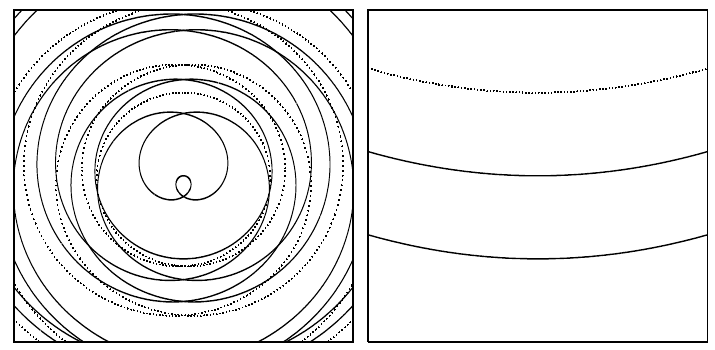
Fig. 3. Star tracks in the focal plane of the “Lyra-B” telescope pointed to the pole of the orbit. Left: the case of the fixed telescope; right: the case of the telescope rotating with the orbital period (the curvature of the tracks is increased by a factor of 30). Note that the left-hand panel differs appreciably from classical photos of “star arcs” taken with a fixed camera. This is because we observe the central part of the pattern, where linear velocities of star images due to rotation are comparable to the precession